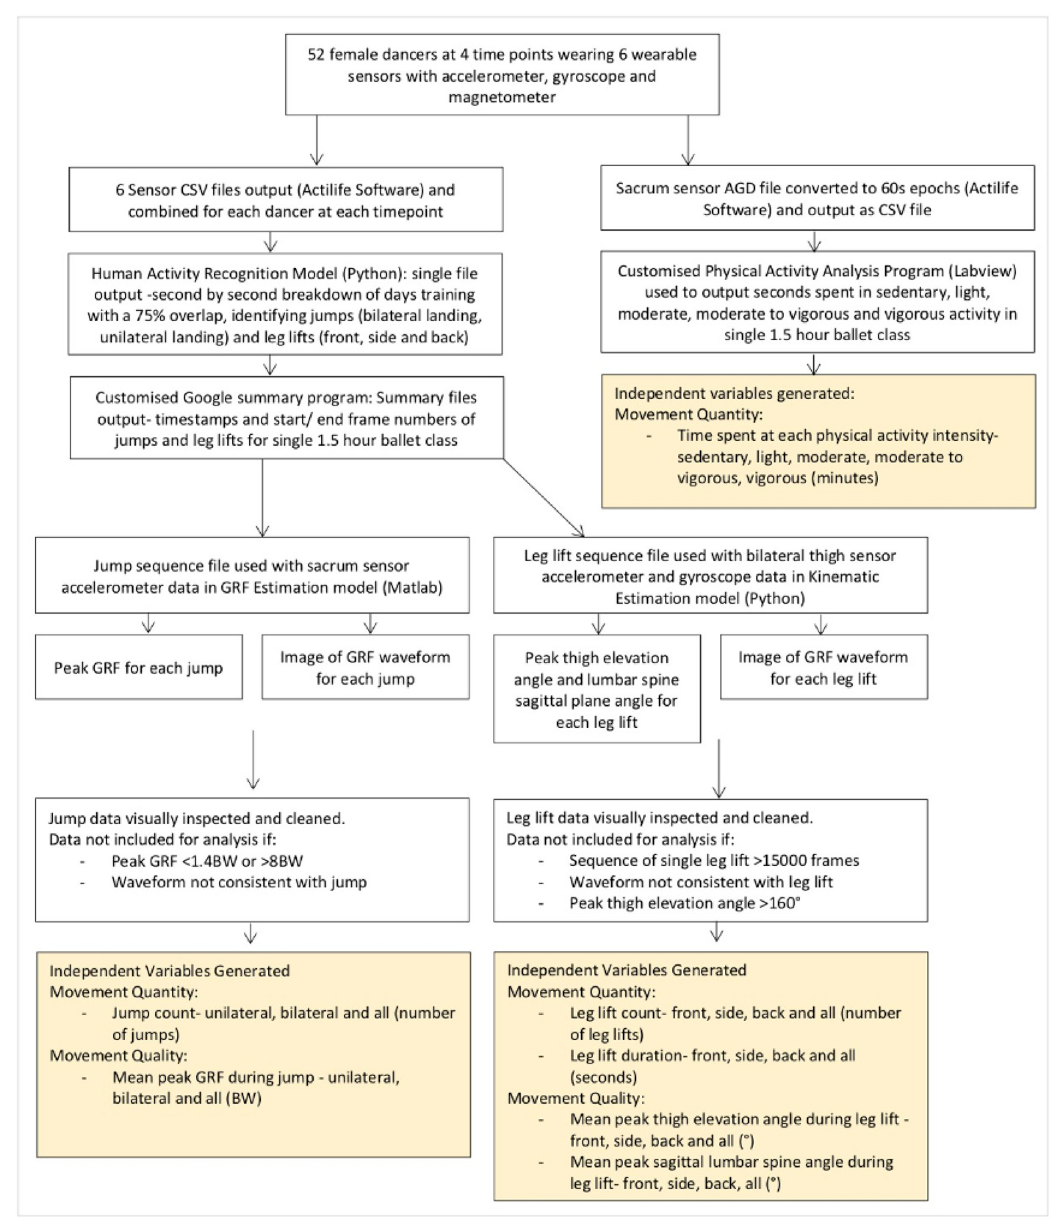
Fig 2. Flow diagram representing sensor data processing steps and variables